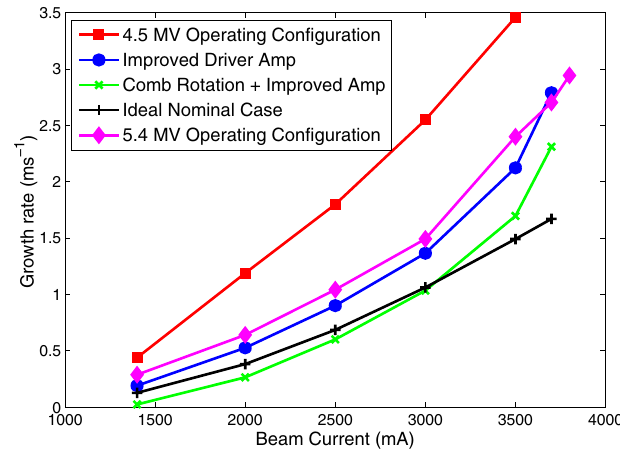
FIG. 15. (Color) Estimated growth rates. Values up to 2500 mA validated for LER with the physical system as shown in Fig.